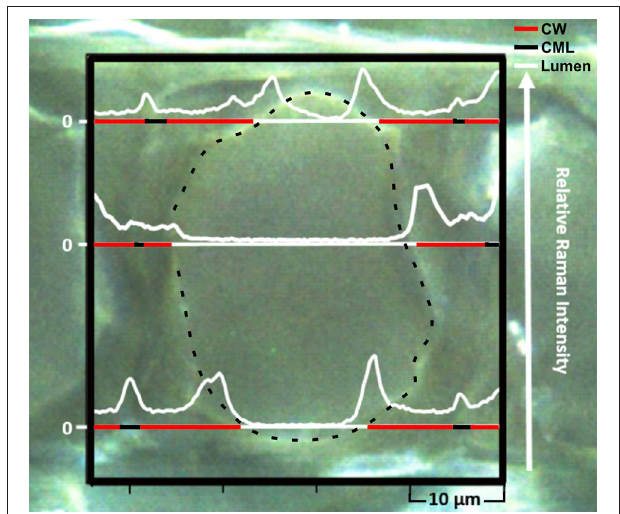
FIGURE 3 | Microscope image overlaid with single lines extracted from the hyperspectral Raman mapping showing the resonance fluorescence intensity (2480 cm − 1 ) profile of Eu:HfO 2 nanoparticles infiltrated in the wood ultrastructure. (CW, cell wall; CML, compound middle lamella; dashed line, cell wall/lumen